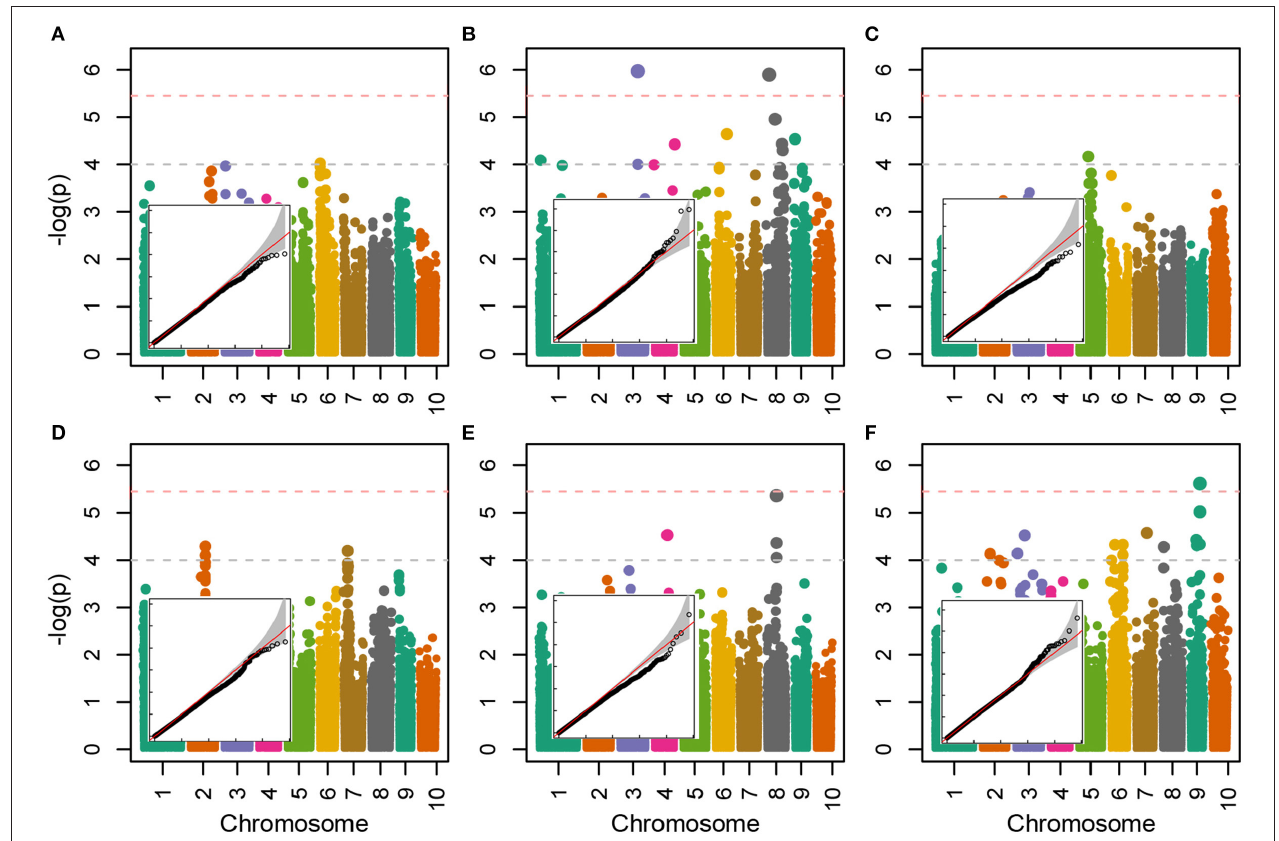
FIGURE 5 | Manhattan and quantile-quantile plots of the –log(p) values of associations of the trait fold-change values between CO and WW for CWC (A) , proline (B) , H 2 O 2 (C) , PROT (D) , GPOD (E) and TBARS (F) . Horizontal dashed lines represent arbitrary threshold of 4 (gray) and Bonferroni threshold of 5.45 (light